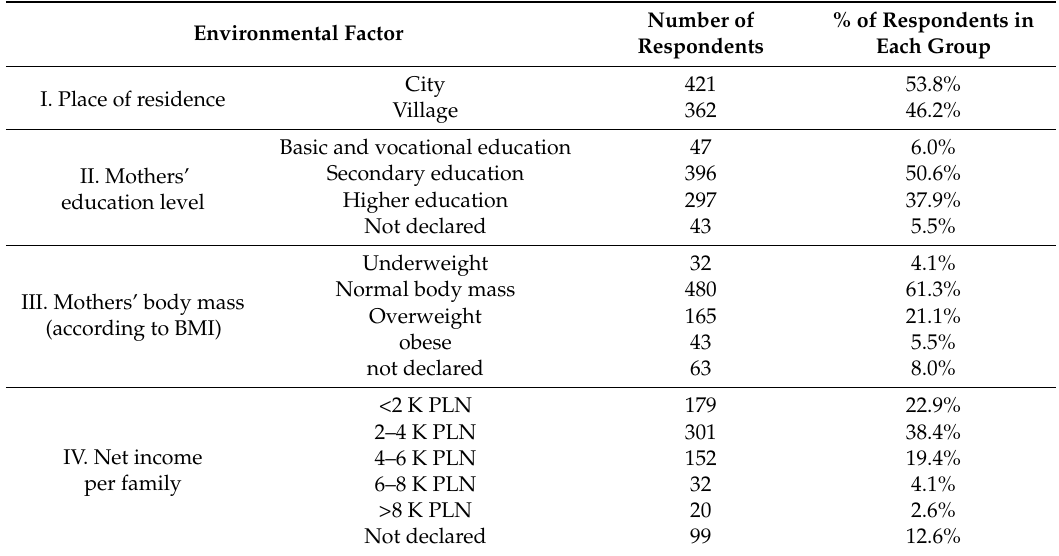
Table 1. Characteristics of respondents’ sample ( n = 783).